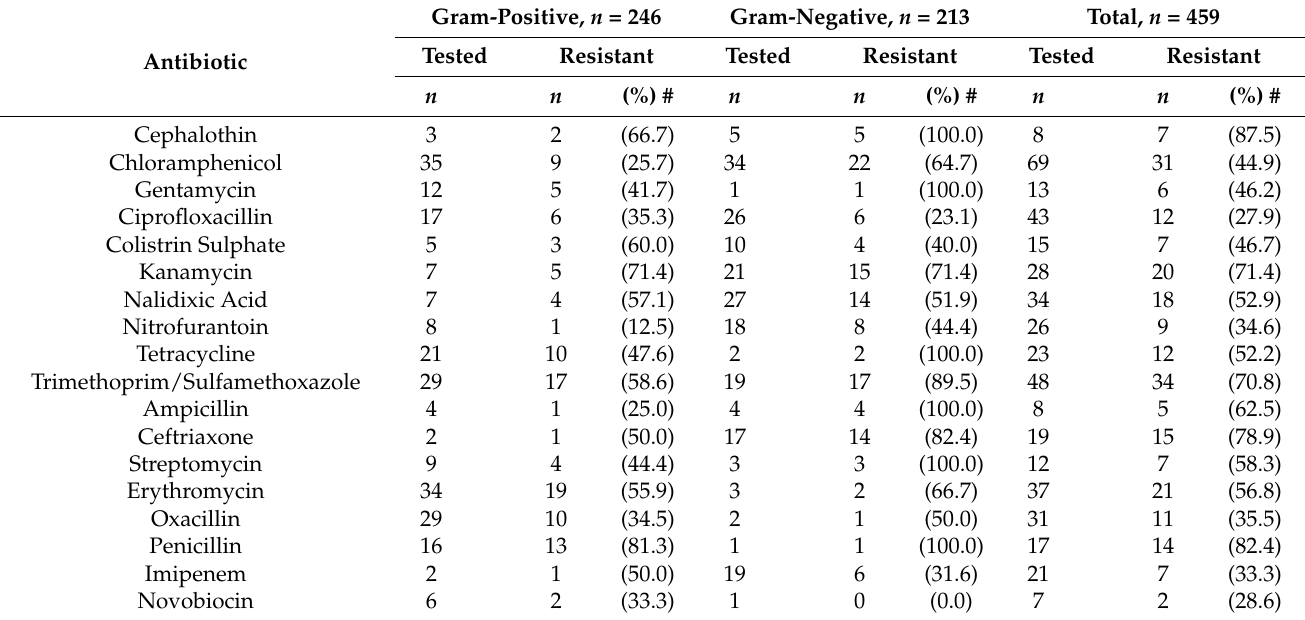
Table 3. Antibiotic sensitivity testing and antimicrobial resistance patterns stratified by Gram-staining among samples with positive bacterial isolates from two referral hospitals (pediatric and maternity) in Freetown, Sierra Leone, from 2017 to 2019.